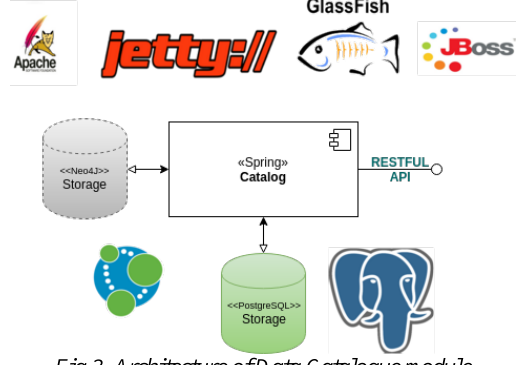
Fig.3. Architecture of Data Catalogue module